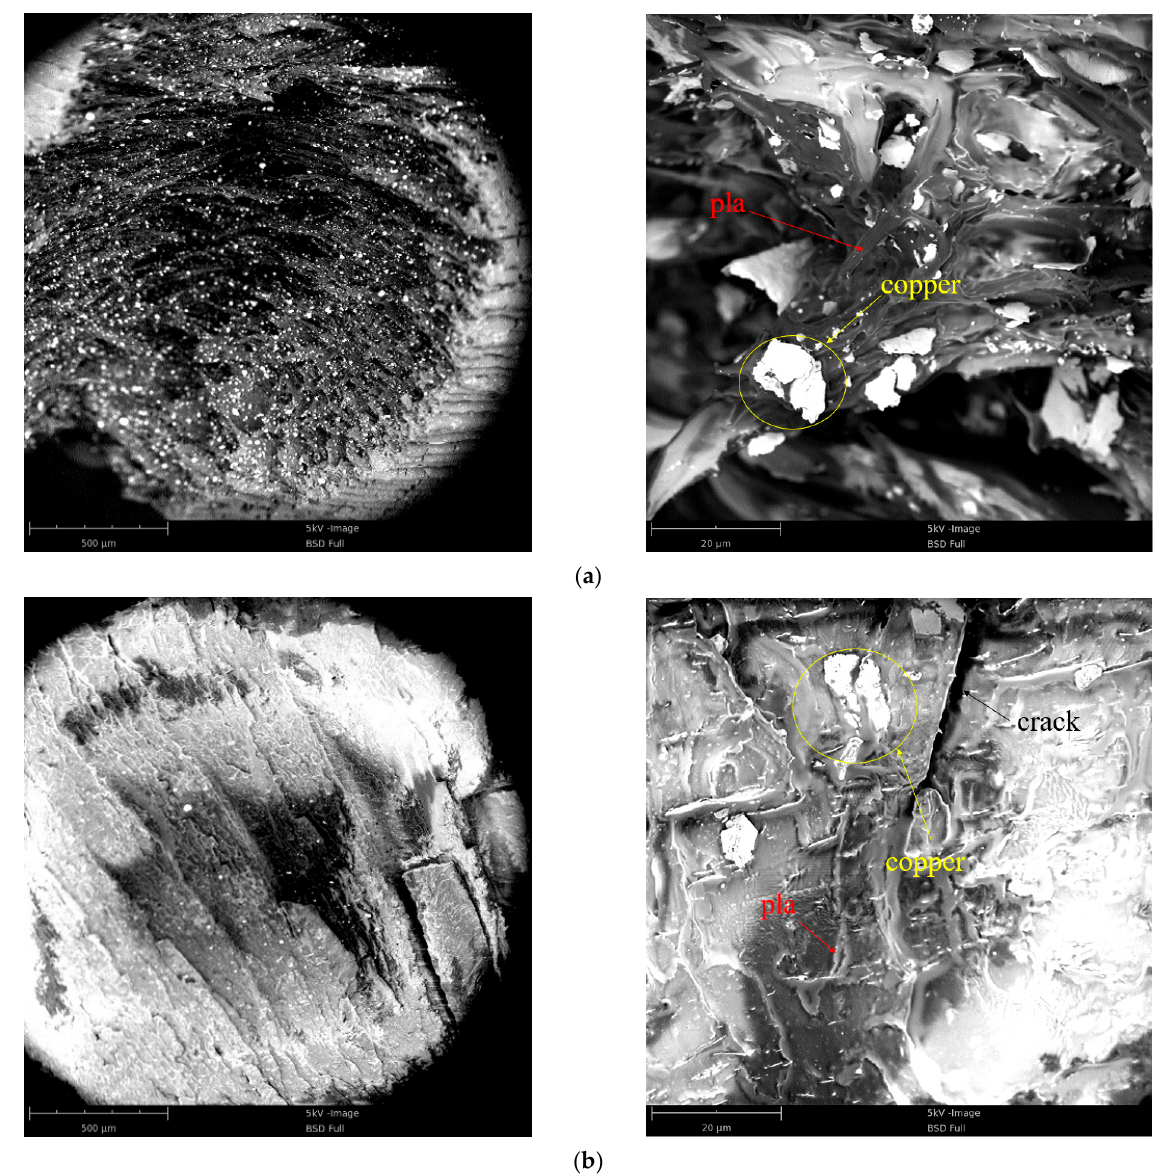
Figure 10. SEM image of sample. ( a ) Quasi ‐ static compression crevasse; ( b ) dynamic impact cross section. Figure 10b demonstrates the cross section formed from the PLA ‐ Cu specimen that was subjected to dynamic loading. The failure mode under this condition was signifi ‐ cantly different from that under the condition of quasi ‐ static compression. Particularly, the PLA ‐ Cu material experienced a fully brittle fracture mode, wherein a large amount of plastic deformation occurred on the surface of the fracture. Additionally, a lamellar shed ‐ ding phenomenon occurred. Considering these results and those obtained via quasi ‐ static compression, we can assume that the presence of copper powder improves the static com ‐ pressive strength of PLA material. 4. Constitutive Model 4.1. Parameter Fitting of ZWT Constitutive Model The dynamic mechanical behavior of polymers can be described by applying the ZWT constitutive model [24–28]. The ZWT model is a nonlinear viscoelastic constitutive